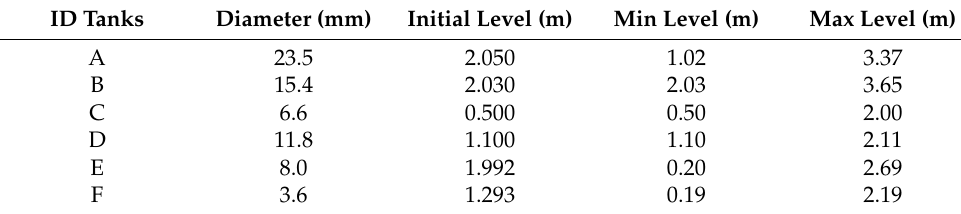
Table 5. Richmond network tank